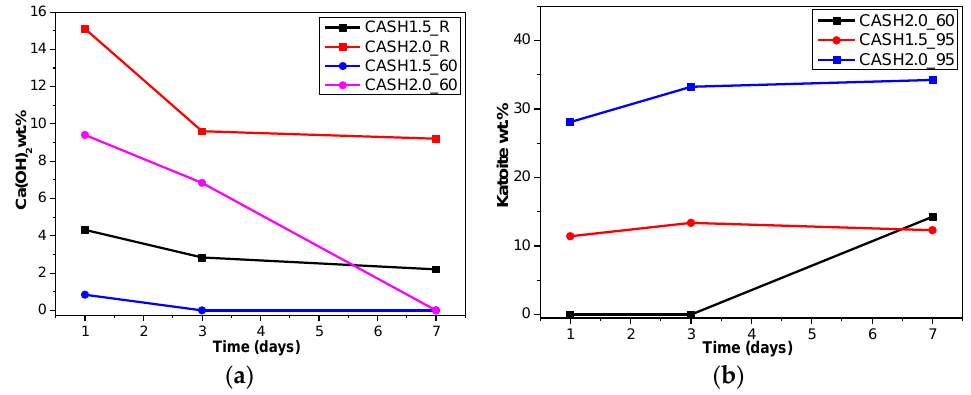
Figure 4. Calcium hydroxide and katoite content on different days. ( a ) Calcium hydroxide; ( b ) Katoite.